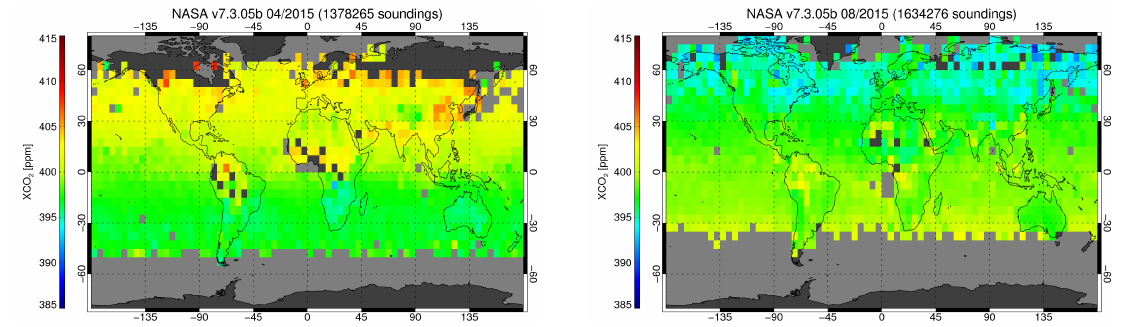
Figure 14. NASA v7.3.05b monthly mean XCO 2 at 5° × 5°. Left : April 2015. Right : August